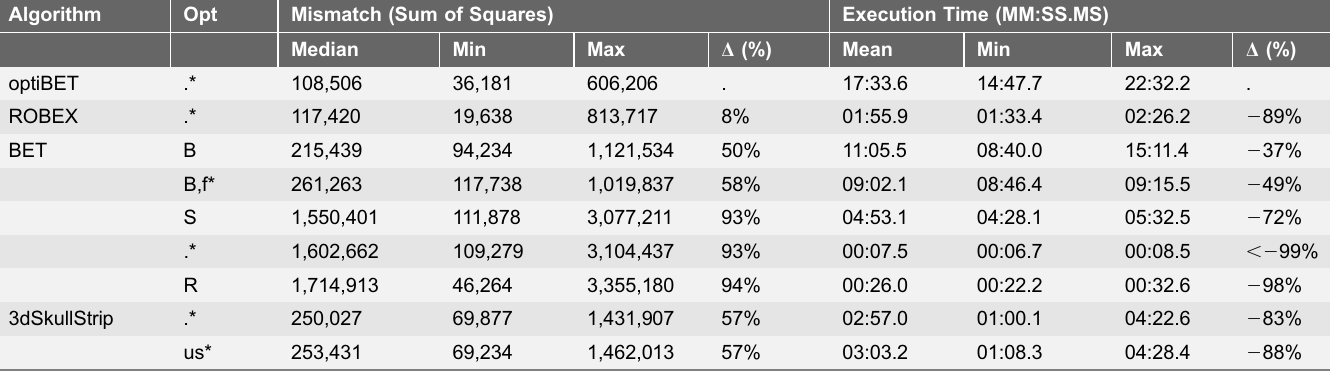
Table 2. Relative performance summary (over all 74 subjects) for each brain extraction algorithm and tested option. Algorithm